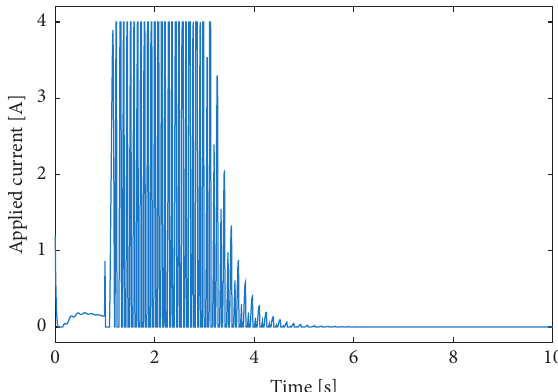
Figure 14: Current input for the system with the proposed algorithm.